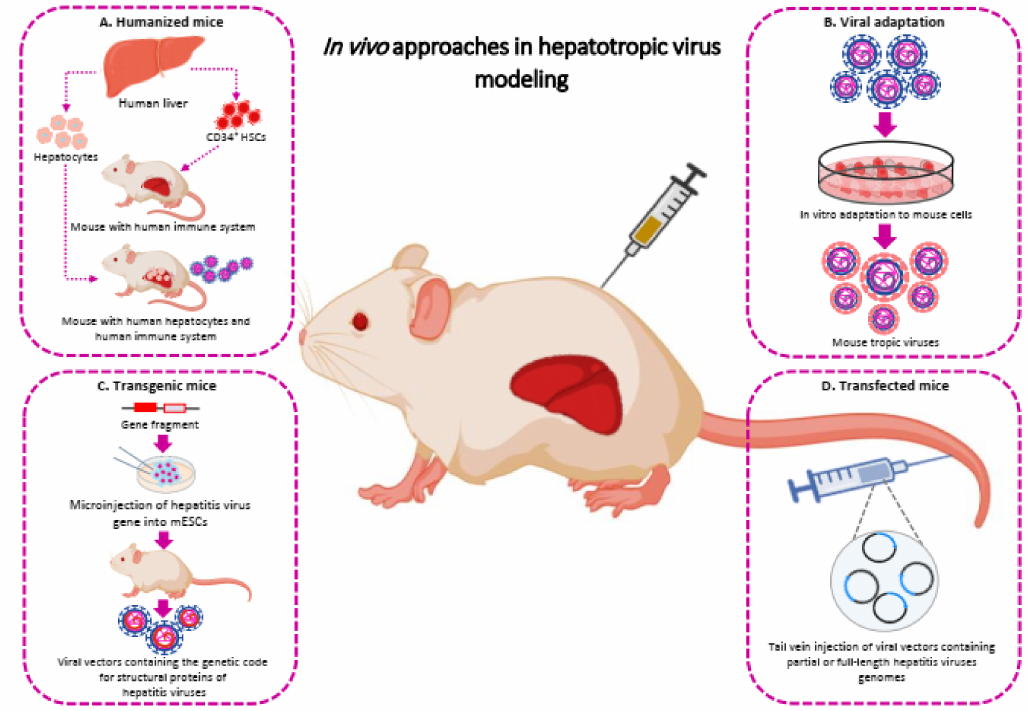
Figure 2. Overview of the main current in vivo approaches used to study hepatotropic virus infections. ( A ) Humanized mice. Human cells (HSCs and hepatocytes) are injected into the spleen and portal veins of uPA/RAG-2, uPA/SCID, TK-NOG, and FRG mice. These cells migrate to the liver via the splenic and portal veins, engraft into the liver structure, and proliferate. ( B ) Viral adaptation. In vitro adaptation of hepatotropic viruses to mouse cells, may adapt these viruses to the murine environment. ( C ) Transgenic mice. Microinjection of structural viral genes into mESCs used to develop HBV/HCV transgenic mice. ( D ) Transfected mice. This model can be constructed by hydrodynamic injection and adeno-associated viral transfection of viral vectors containing partial or full-length hepatitis virus genomes. Abbreviations. FRG, Fumaryl acetoacetate hydrolase (Fah)/RAG2/interleukin (IL) 2-gammaC (FRG) triple mutant mice; HSCs, Hematopoietic stem cells; mESCs, Mouse embryonic stem cells; TK-NOG, a NOG mouse expressing a thymidine kinase transgene (NOG-Tg(Alb- UL23)7-2/ShiJic); uPA/RAG-2, urokinase-type plasminogen activator (uPA)/recombinant activation gene-2